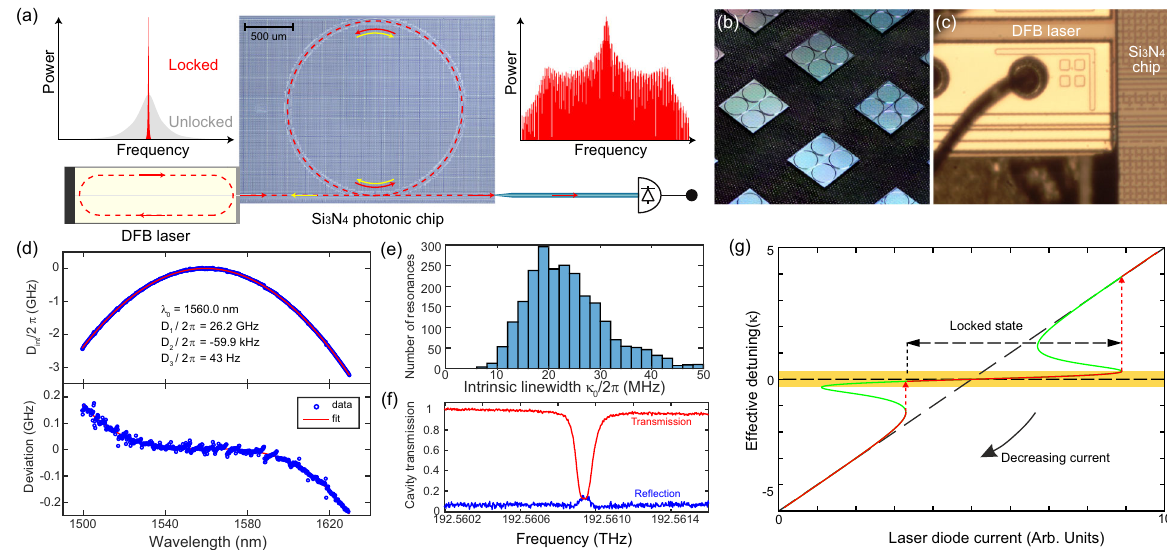
Fig. 1 Principle of platicon microcomb generation using laser self-injection locking. a Schematic of platicon generation using a DFB laser self-injection- locked to a photonic chip-based, high- Q , Si 3 N 4 microresonator. The bulk and surface Rayleigh scattering inside the Si 3 N 4 microresonator induces back- scattered light that is sent back to the DFB laser and triggers laser self-injection locking. This results in laser linewidth (i.e. frequency noise) reduction. Further increasing the laser power can trigger platicon formation due to the nonlinear interaction of counter-propagating cavity modes and modi fi ed laser dynamics due to the narrow-bandwidth Rayleigh backscattering. b Photograph of Si 3 N 4 chips. c Photograph showing the DFB laser edge-coupled to a Si 3 N 4 waveguide. d Top: Measured integrated dispersion of the Si 3 N 4 microresonator. This microresonator has an FSR of 26.2 GHz in the microwave K-band and a normal GVD of D 2 /2 π = − 59.9 kHz. Bottom: The dispersion deviation from the D 2 -dominant parabolic pro fi le reveals avoided mode crossings and higher- order dispersion terms. e Histogram of 2414 fi tted intrinsic resonance linewidth κ 0 /2 π . The most probable value is κ 0 /2 π = 19 MHz, corresponding to an intrinsic Q 0 = 10 7 . f Microresonator transmission (red) and re fl ection (blue) traces showing the resonance with 15% back-re fl ection. g Simpli fi ed analytical estimation of laser frequency tuning curve based on the model of linear self-injection-locking illustrated in ref. 59 (ESA). The DFB laser, whose optical spectrum is shown in Fig. 2a (inset), can either be in the free-running state or the self- injection-locked state. The operation state depends on the fre- quency detuning between the microresonator resonance and the DFB laser-cavity resonance that is controlled by the laser bias current. Figure 3a shows the schematic of the experimental setup.